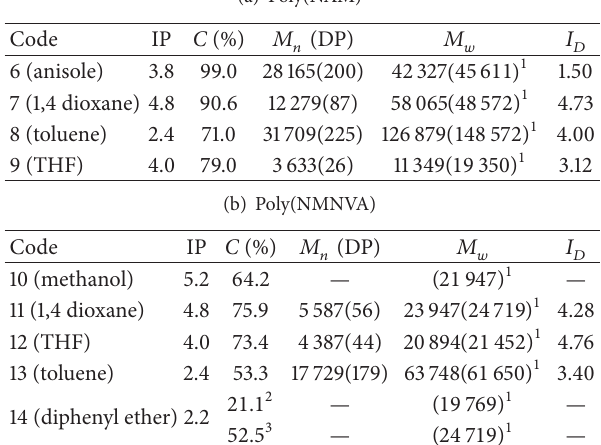
Table 3: Dimensional characteristics of poly(NAM) and